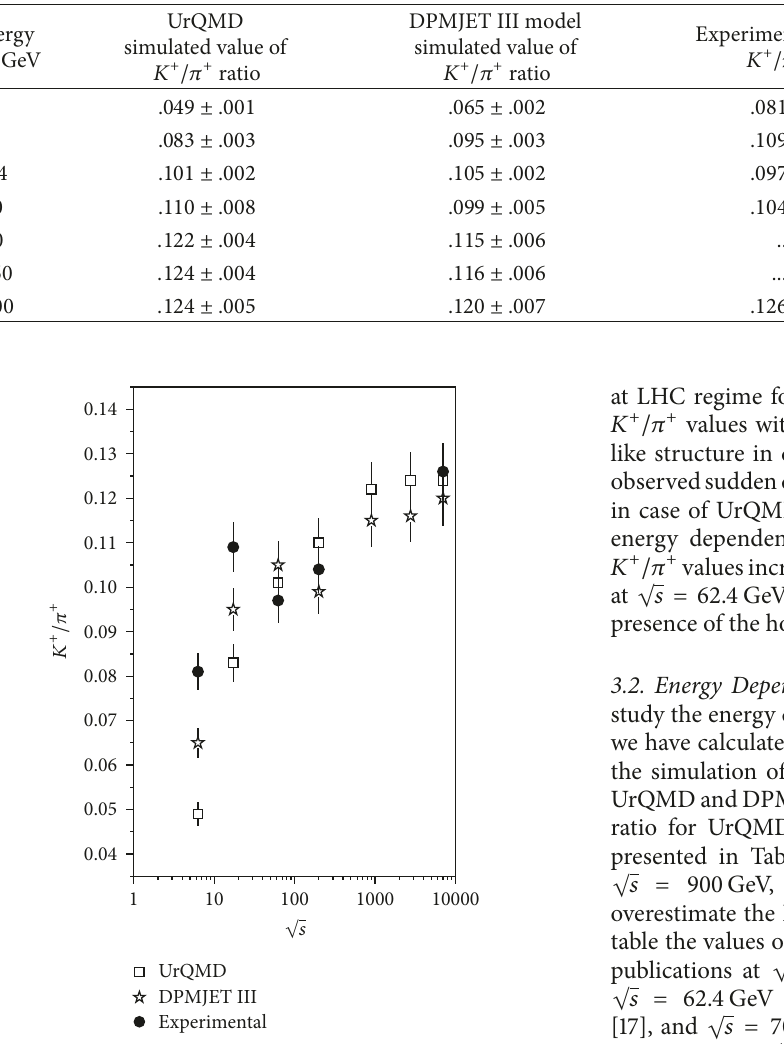
Figure 1: It represents the energy dependence of 𝐾 + /𝜋 + ratio in pp collisions at √𝑠 = 6.3 GeV to 7 TeV of the UrQMD, DPMJET III, and experimental